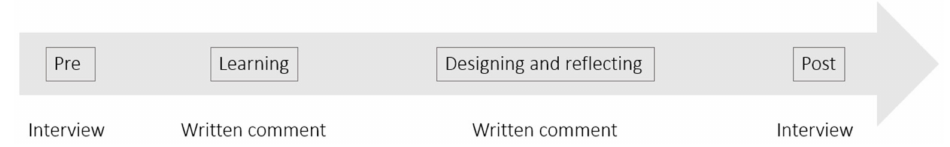
Figure 3. General design of the